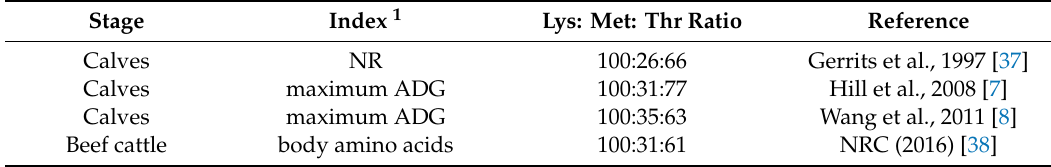
Table 7. The amino acid ratio of calves and cows in previous